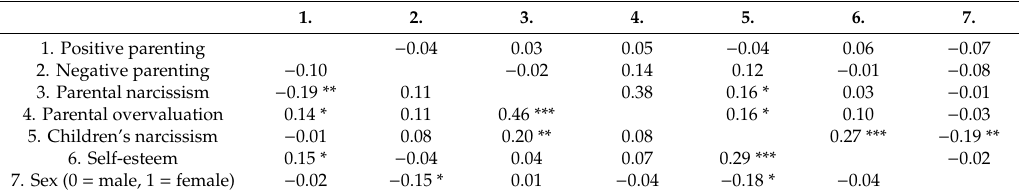
Table 2. Bivariate correlations among the latent and control variables of the study after estimating the structural equation models, specifying all covariances between them for both the mother–child and father–child